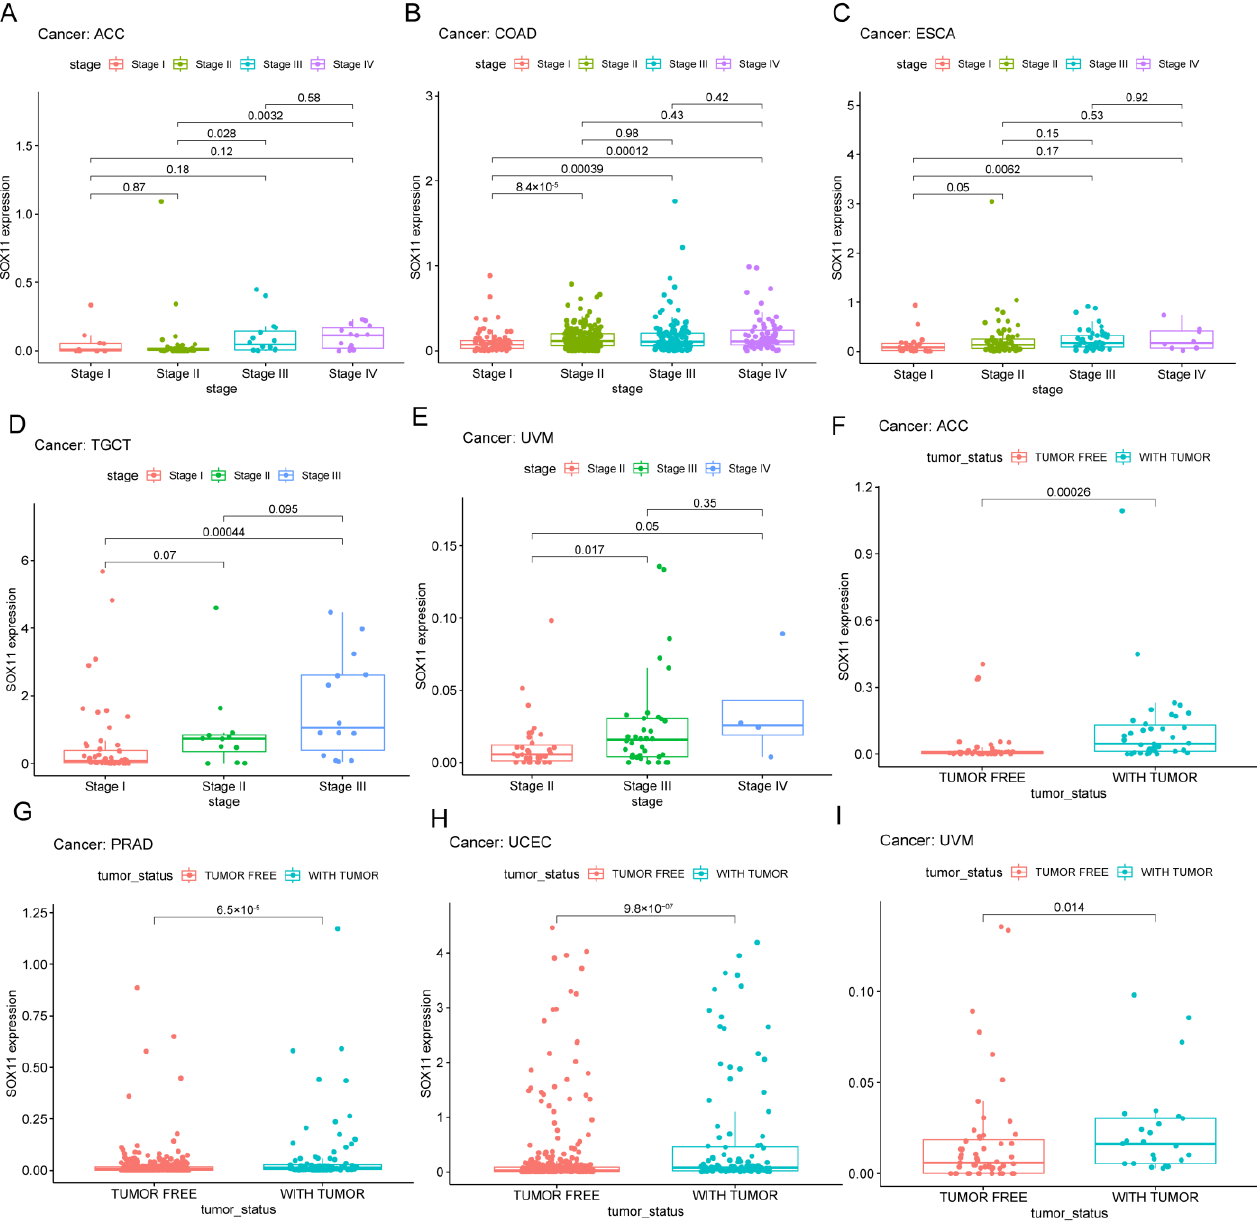
Figure 5. Correlation between SOX11 expression and Clinicopathological Phenotype. ( A – E ) Correlation between SOX11 expression and clinical stage. ( F – I ) Correlation between SOX11 expression and tumor status.